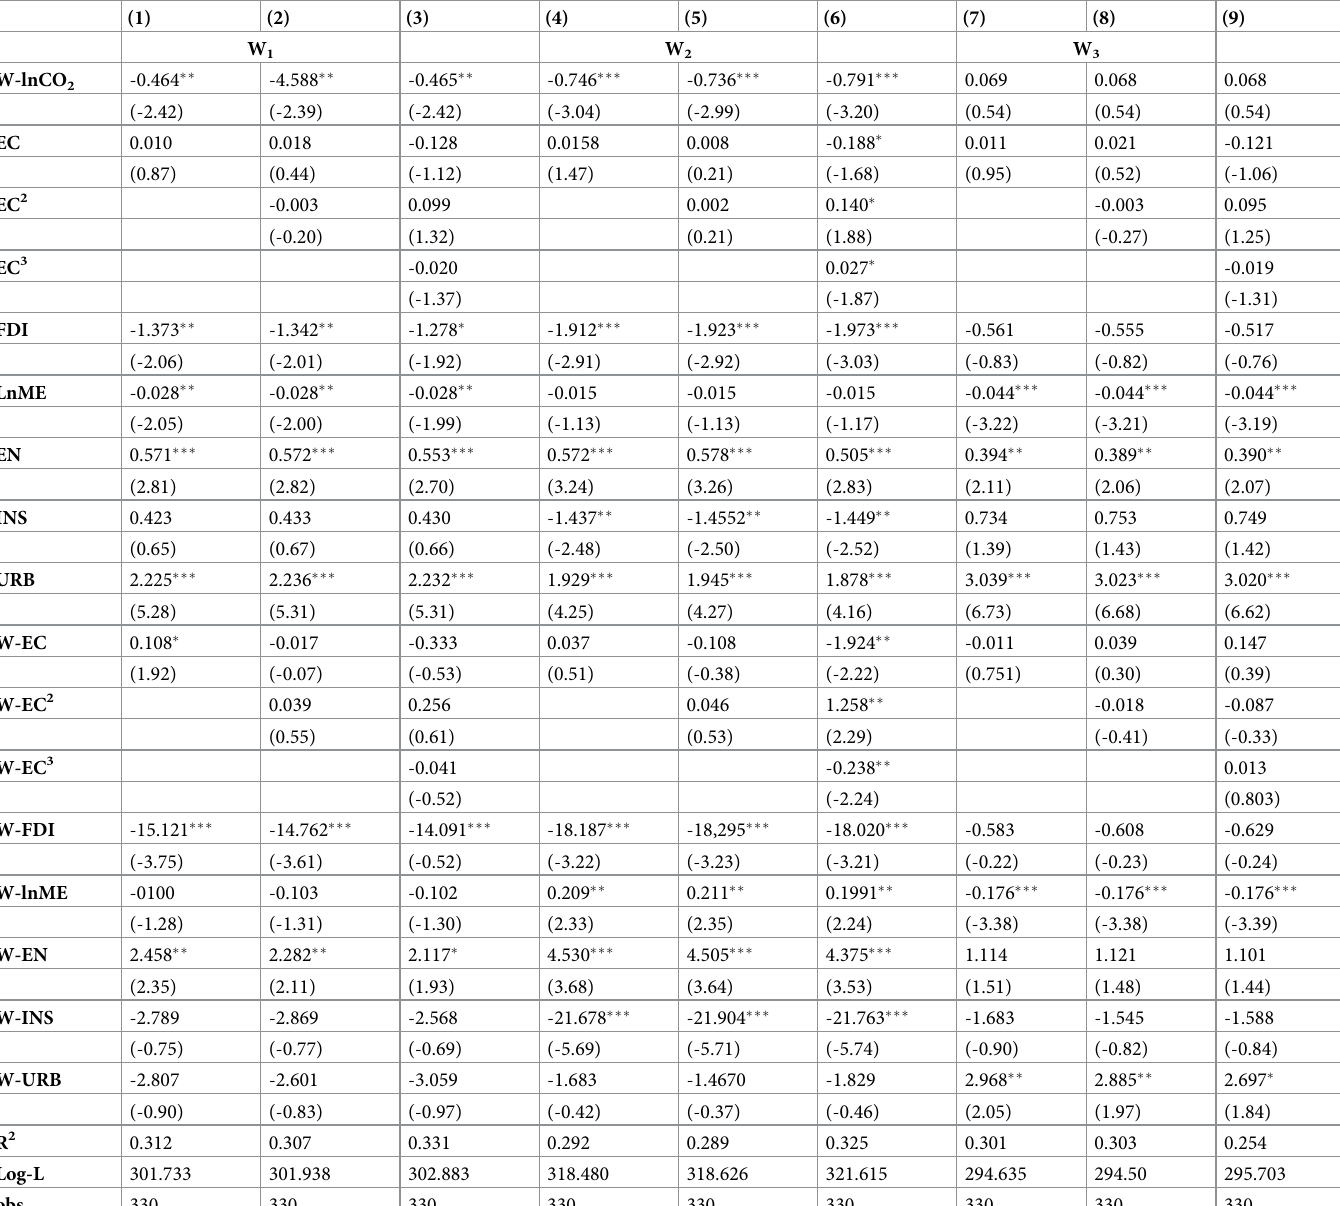
Table 10. Estimation results of